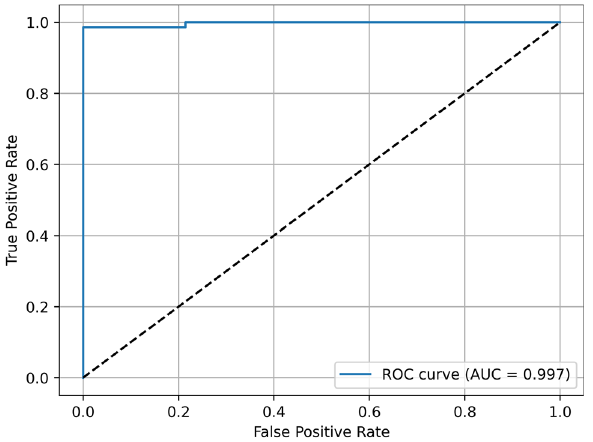
Figure 2. Area-under-the-curve-receiver-operating-characteristics-curve. The ROC is created by plotting the true positive against the false positive rate at different thresholds.